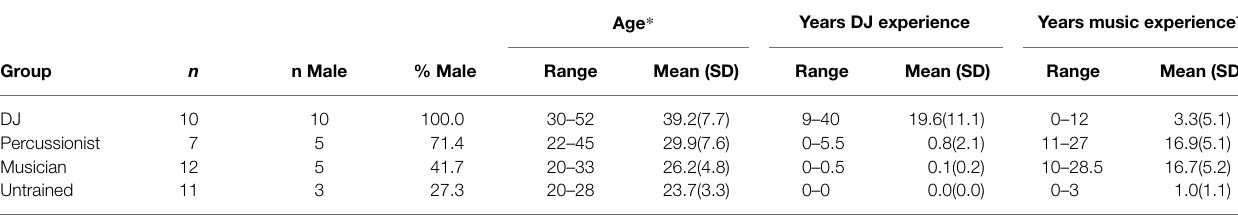
TABLE 1 | Participant